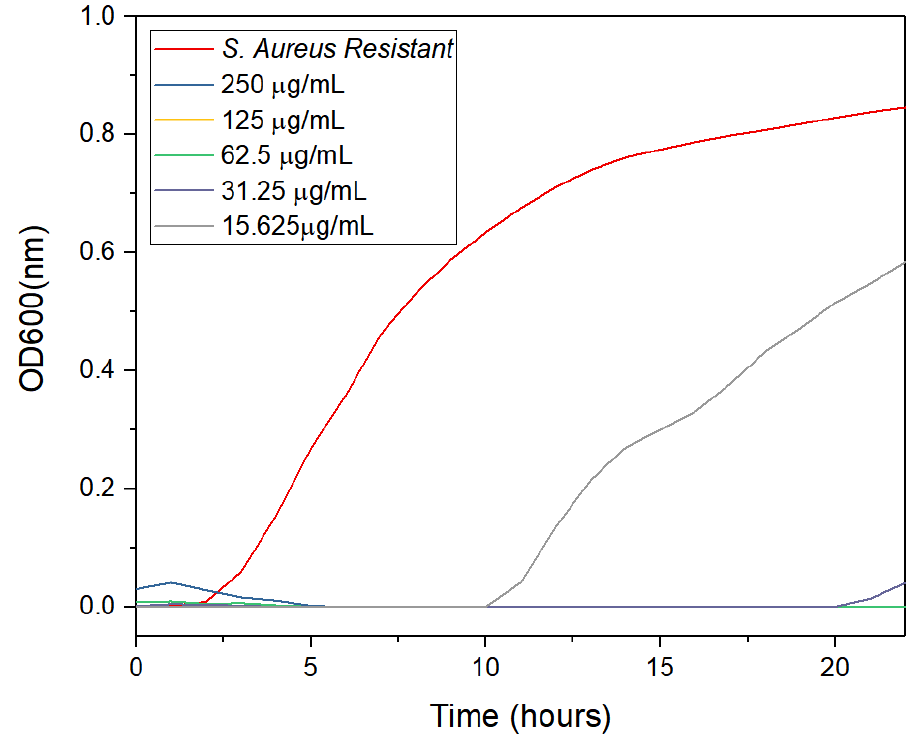
Figure 14. Antimicrobial activity of the AgNPs synthesized with lemon, orange, and grapefruit peel extract at different times.